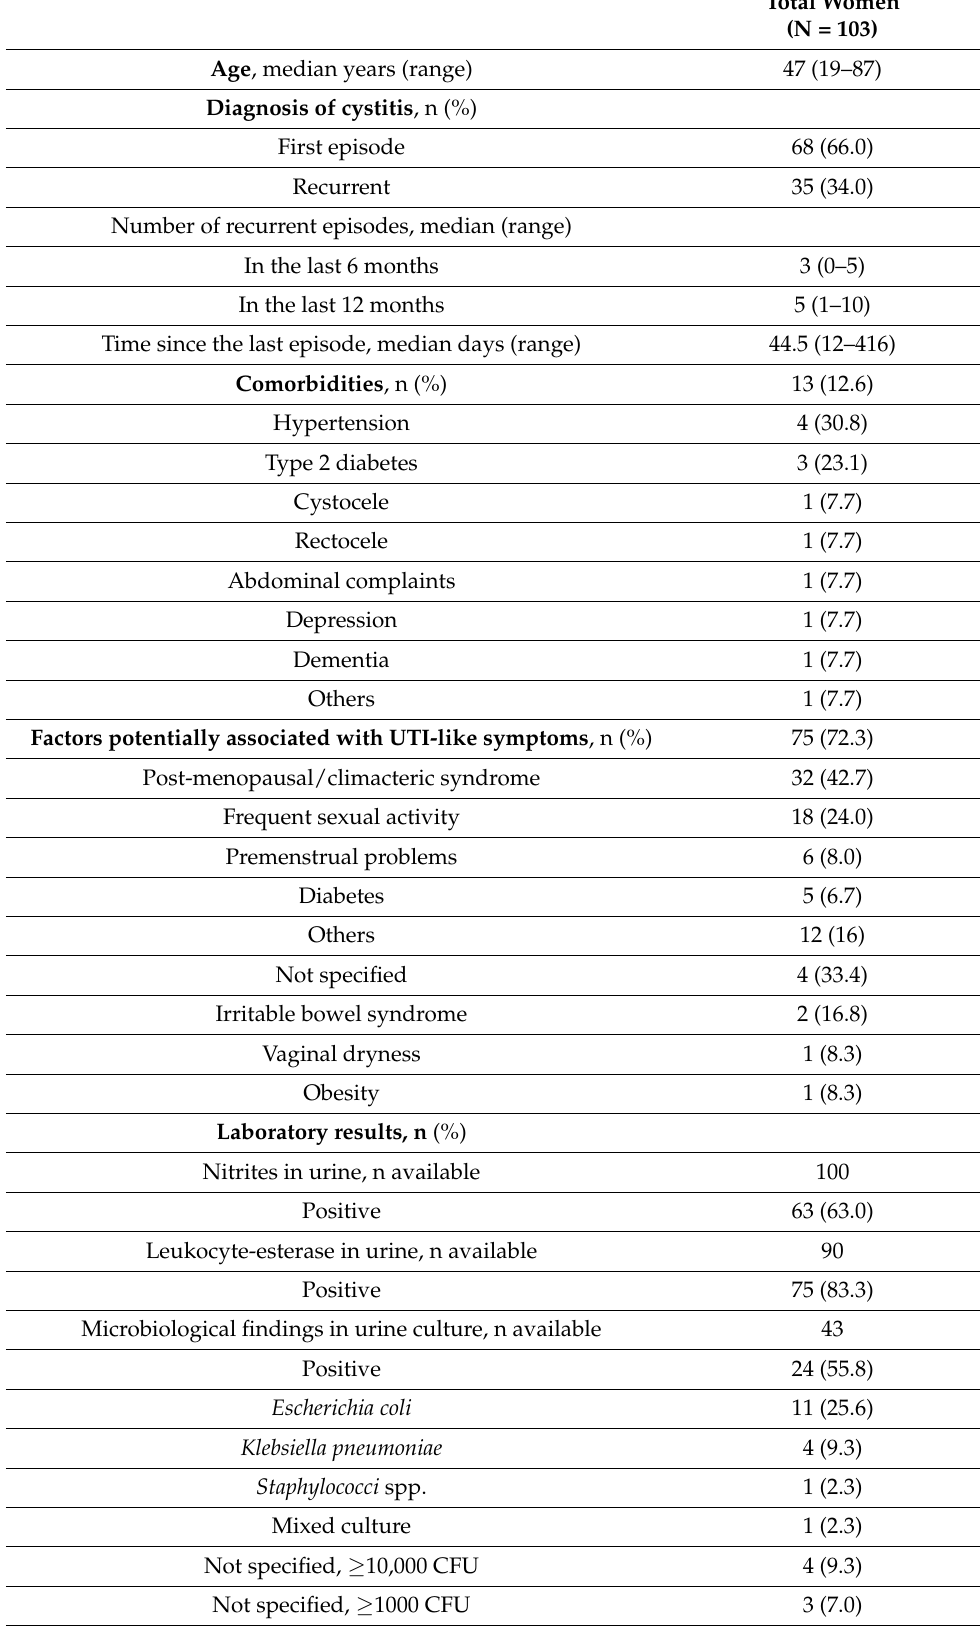
Table 1. Sociodemographic and clinical characteristics of